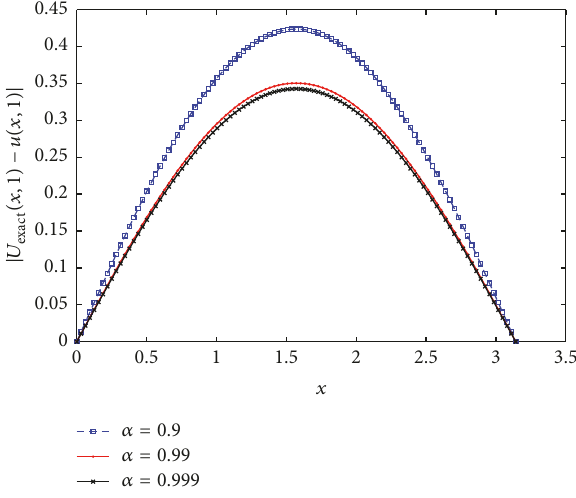
Figure 2: Errornorm 𝐿 ∞ forExample5( 𝛼 = 0.9 − ◻ ; 𝛼 = 0.99 − ∘ , and 𝛼 = 0.999 − × ) at 𝑇 = 1